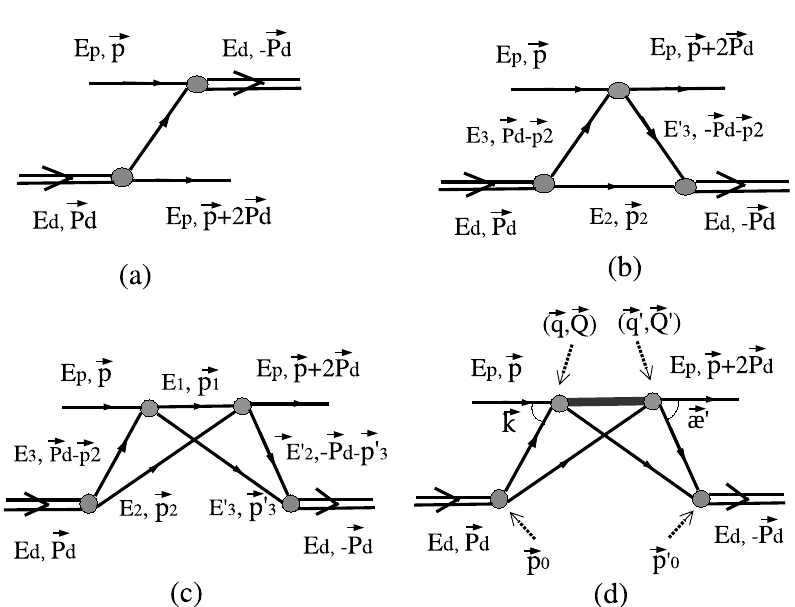
Figure 1: The diagrams included into consideration: (a) the one-nucleon exchange diagram; (b) the single scattering diagram; (c) the double scattering diagram with a nucleon in the intermediate state; (d) the double scattering diagram with ∆ -isobar in the intermediate